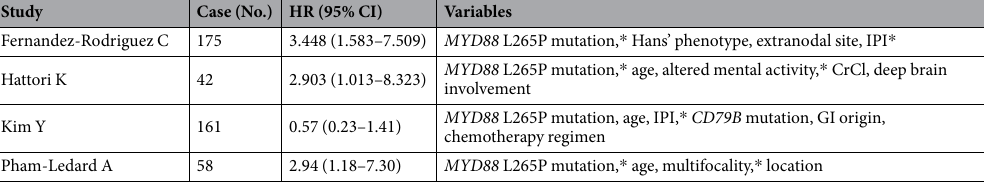
Table 2. Hazard ratios and covariates used in the multivariate survival model. HR; hazard ratio, CI; confidence interval, IPI; international prognostic index, GI; gastrointestinal * ; independent prognostic variables, P < 0.05, CrCl; creatinine clearance.